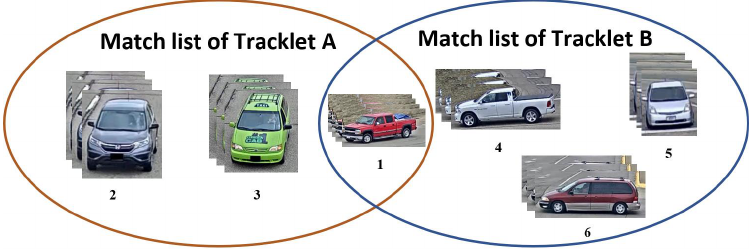
Figure 4. A Candidates Intersection Ratio